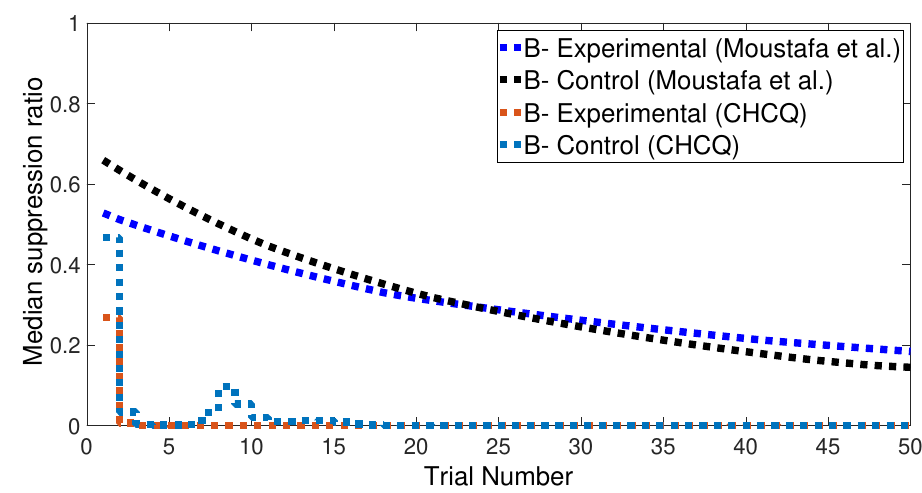
Figure 13. Blocking task for the lesioned system.